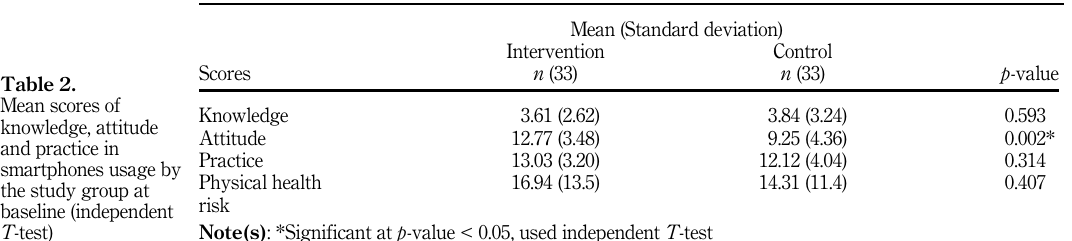
Table 1. Comparison of the sociodemographic characteristics between the intervention and control groups at baseline